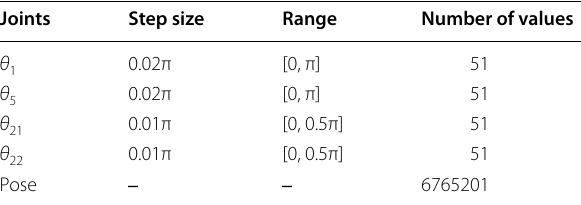
Table 5 Step sizes of the active joints